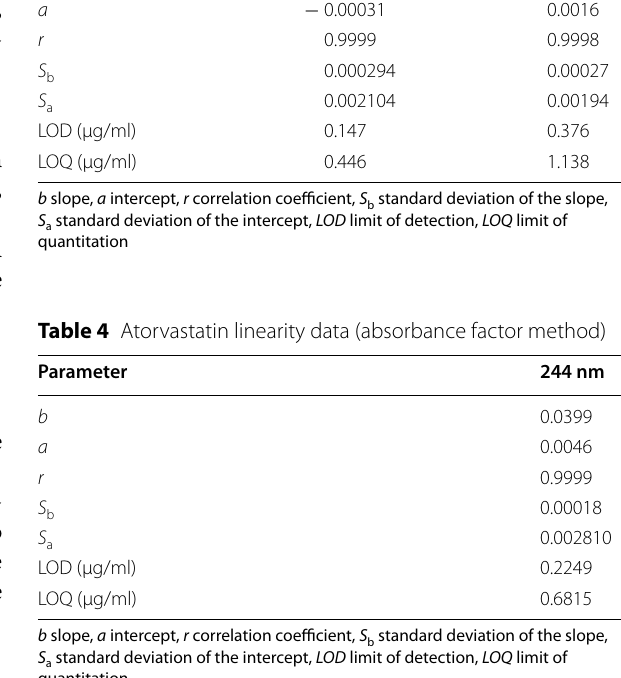
b slope, a intercept, r correlation coefficient, S b standard deviation of the slope,